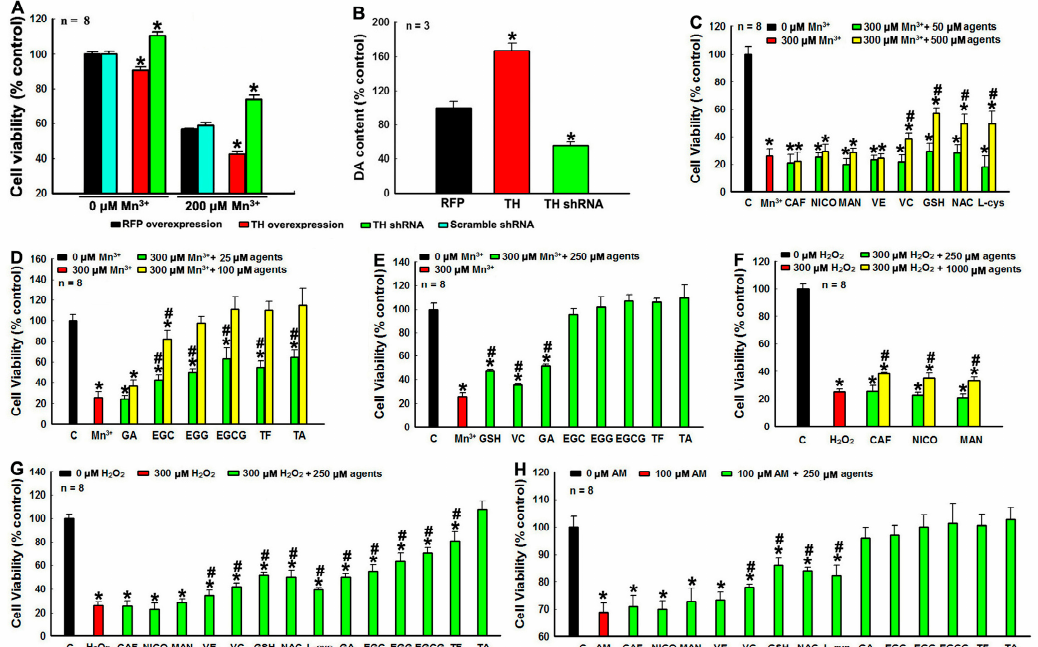
Figure 5. Protection against Mn3+, H2O2, and AM induced dopaminergic PC12 cell death by tea polyphenols and other agents. Dopaminergic PC12 cells were challenges with 200 or 300 μ M Mn 3+ or 300 μ M H 2 O 2 overnight or 100 μ M AM 3 h respectively in the presence or absence of various agents. Cells without any challenges are set as control. *, at least p < 0.05, compared with cell viability of control cells. #, at least p < 0.05, compared with cell viability of cells challenged with stressors only. ( A , B ), The Mn 3+ induced cell toxicity are dependent on endogenous DA level in PC12 cells. ( A ) Influence on PC12 cell viability by tyrosine hydroxylase (TH) overexpression or knockdown under Mn 3+ overnight challenge. PC12 cells were transfected with rat-TH or TH shRNA vectors overnight respectively, before subsequent 200 μ M Mn 3+ overnight challenge. ( B ) Influence on DA level in PC12 cells by TH overexpression or knockdown. ( C – E ) Protection of PC12 cells against 300 μ M Mn 3+ overnight challenges induced toxicity by different agents. ( C ) Protection by 50 and 500 μ M CAF, NICO, MAN, VE, VC, GSH, and L -cys. ( D ) Protection by 25 and 100 μ M GA, EGC, EGCG, TF, and TA. ( E ) Protection by 250 μ M GSH, L -cys and tea polyphenols. ( F – H ), protection against 300 μ M H 2 O 2 or 100 μ M AM challenges induced toxicity by various agents. ( F ) Protection against H 2 O 2 induced toxicity by 250 and 1000 μ M CAF, NICO, and MAN. ( G ) Protection against H 2 O 2 induced toxicity by 250 μ M agents. ( H ) Protection against 100 μ M AM induced toxicity by 250 μ M agents.